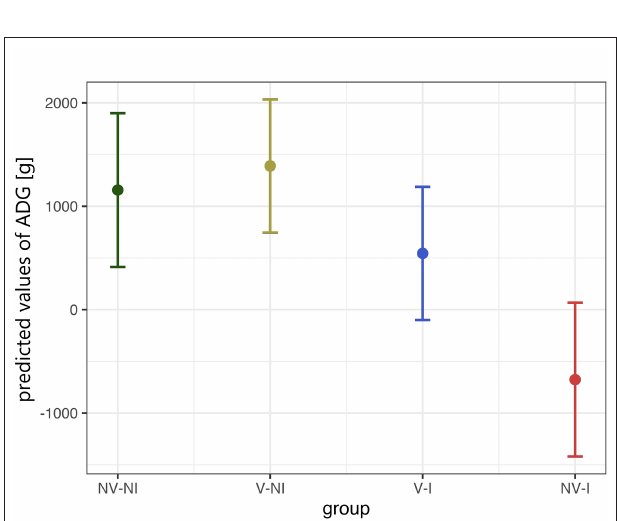
FIGURE 4 | Predicted values of average daily weight gain (ADG) from the day of challenge up to 17 days post-infection in relation to treatment group, calculated with a linear model. Gilts 2 and 22 were excluded from this analysis. The values in the Y-axis represent the predicted daily weight gain in gram. The data points indicate the estimated marginal means of each group, and the error bars illustrate the respective confidence interval (confidence level of 95%). NV–NI, non-vaccinated and non-infected gilts; V–NI, vaccinated and non-infected gilts; V–I, vaccinated and infected gilts; NV–I, non-vaccinated and infected